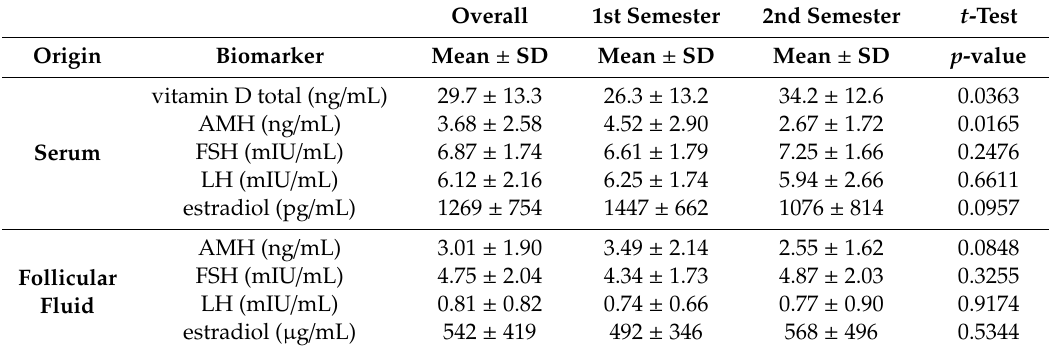
Table 1. Seasonal di ff erences in vitamin D (total) and other biomarkers.